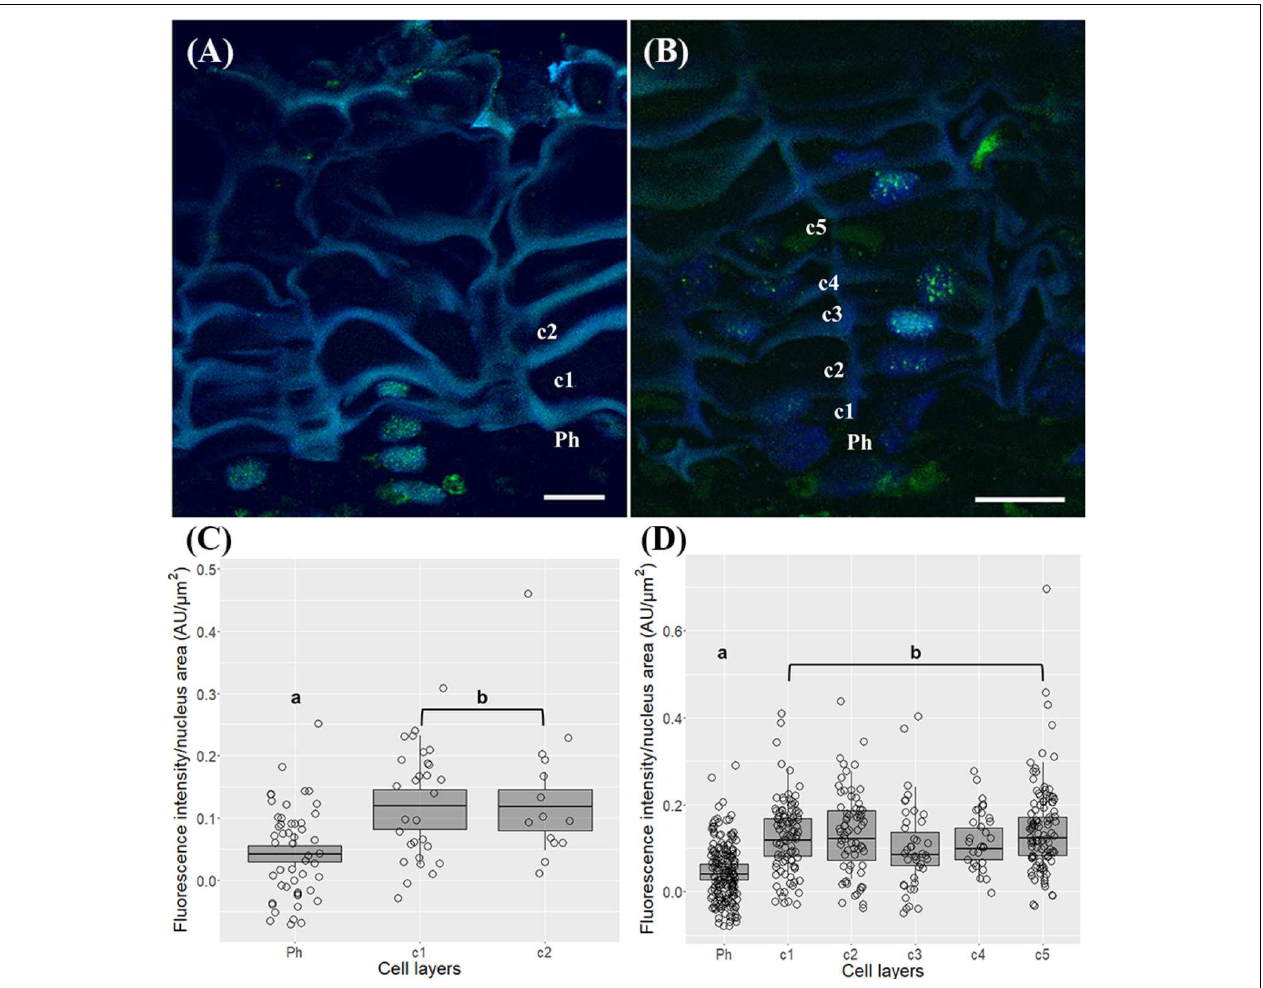
FIGURE 7 | Immunolocalization of the trimethylation of histone H3 at lysine 4 (H3K4me3) in periderms from young sprigs. (A) The nuclei from one-year old sprigs show H3K4me3 signals dispersed throughout the nucleus both in phellogen and cork cell layers c1, c2, c3, and c4 with an enrichment from the phellogen to the two contiguous cork cell layers (c1 and c2) with no differences between them (B) . Three-year old sprigs nuclei show H3K4me3 signals dispersed throughout the nucleus both in phellogen and cork cell layers c1, c2, c3, and c4 (C) with a significant increase from the phellogen to each of the cork cell layers (c1, c2, c3, c4, and c5) and no differences between them (D) ; similar small letters indicate no significant differences. DNA was counterstained with DAPI. Bar = 10 µ m. Ph, phellogen. Boxplots represent minimum fluorescence intensity/nucleus area, first quartile (bottom of box), median, third quartile (top of box), and maximum. The distribution of every individual measurement is represented by jittered